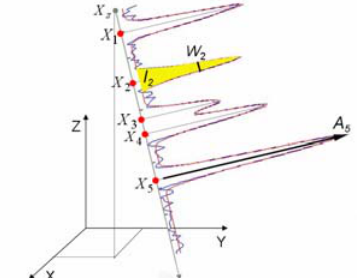
Figure 2 3D points and attributes derived from a waveform